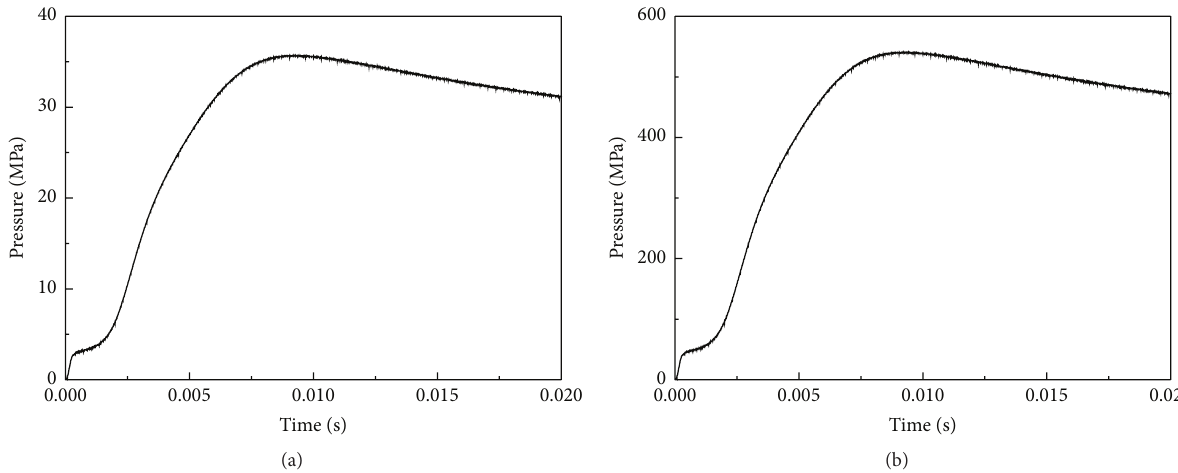
Figure 5: Pressure change by MGGs with different volumes: (a) pressure change of 35 MPa MGG with 10cc volume and (b) internal pressure change of actuator with initial volume of 600 mm 3